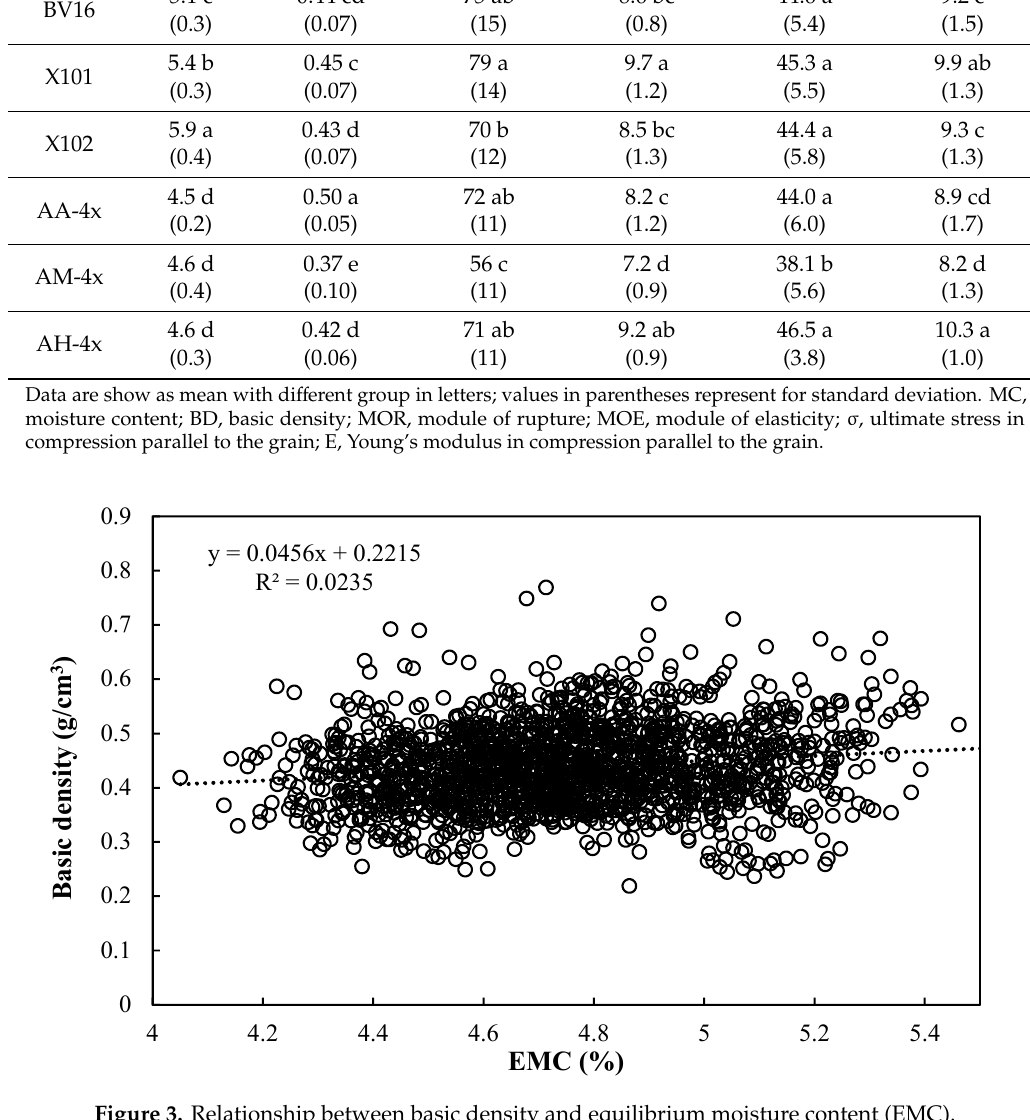
Figure 3. Relationship between basic density and equilibrium moisture content (EMC).